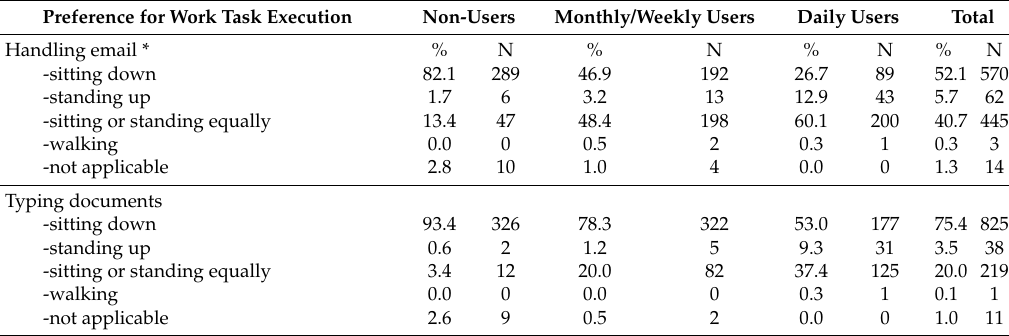
Table A8. Preferred Postures for Work Task